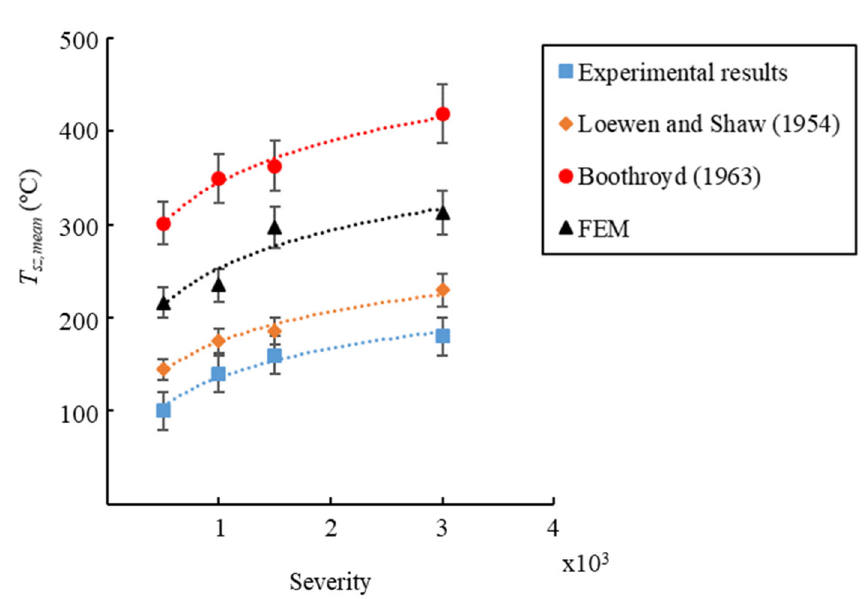
Figure 13. Shear zone temperature as a function of cutting severity. Analytical, experimental and FEM results.